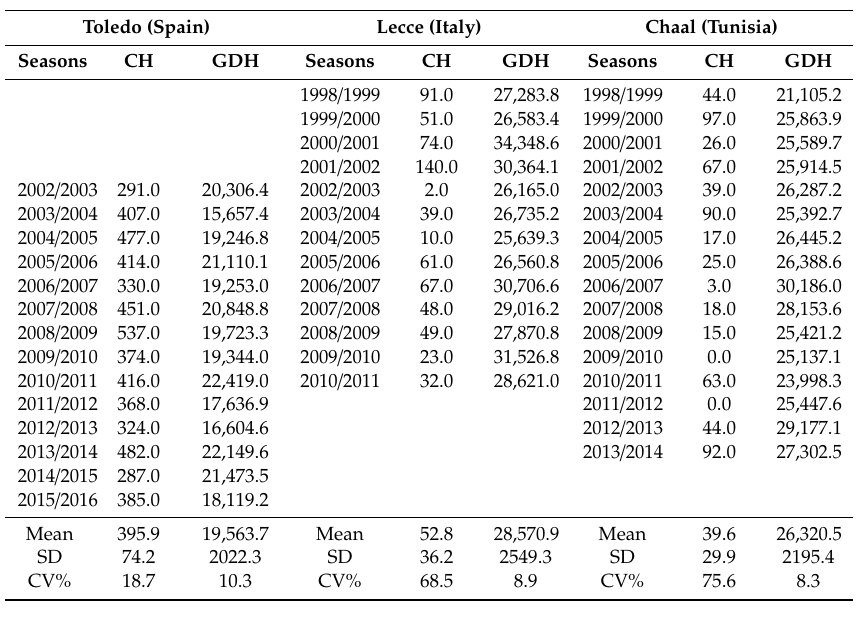
Table 1. Calculations for the Chilling and Heat Requirements According to the Estimated Thermal Accumulation Periods (Heat Requirements have Been Calculated Based on the Optimal Thresholds). CH, Chill Hours; GDH, Growing Degree